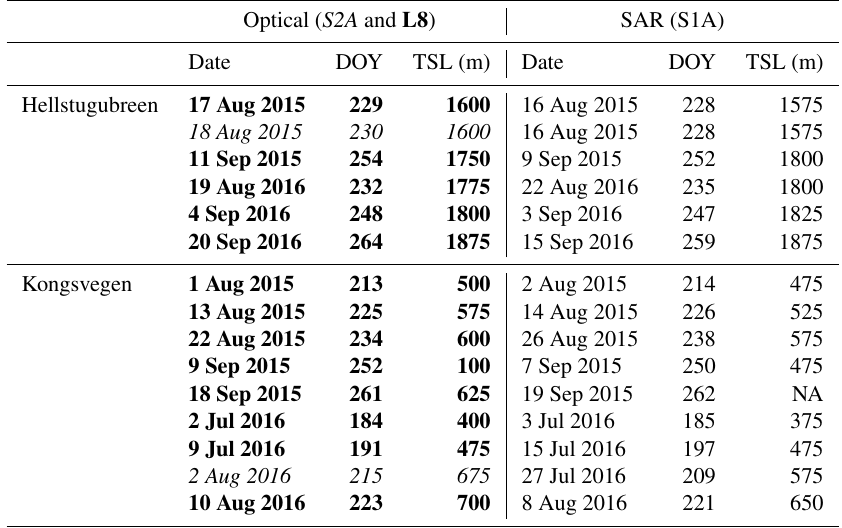
Table A2. Transient snow lines at Hellstugubreen and Kongsvegen derived from Sentinel-2A; Sentinel-2A is S2A in italic font, Landsat 8 is L8 in bold font and Sentinel-1A is S1A in regular